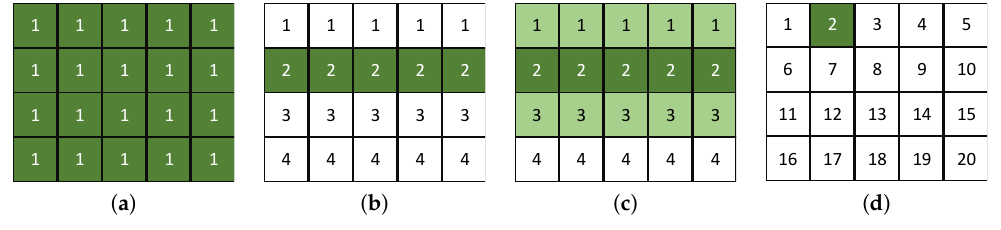
Figure 9. Image model geometries. ( a ) Geometry 1; ( b ) Geometry 2; ( c ) Geometry 3; ( d ) Geometry 4.